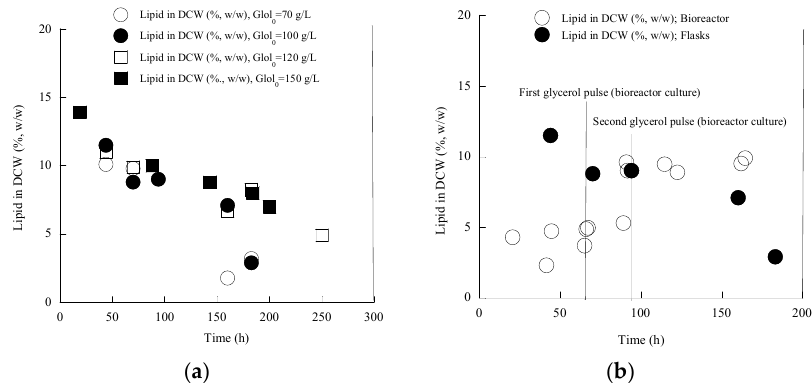
Figure 7. Kinetics of intra-cellular lipids produced per unit of dry cell weight (%, w/w ) of Yarrowia lipolytica LMBF Y-46 during growth on pure glycerol, at various initial glycerol concentrations ( Gly 0 ) imposed under nitrogen-limited conditions in shake-flask experiments ( a ) and shake-flask vs. pulsed fed-batch bioreactor experiments (in the latter case, for the shake-flask experiment, Gly 0 concentration was ≈ 100 g/L). ( b ). Culture conditions as in Tables 1 and 3. Each point is the mean value of two independent determinations (SE ≤ 18%).